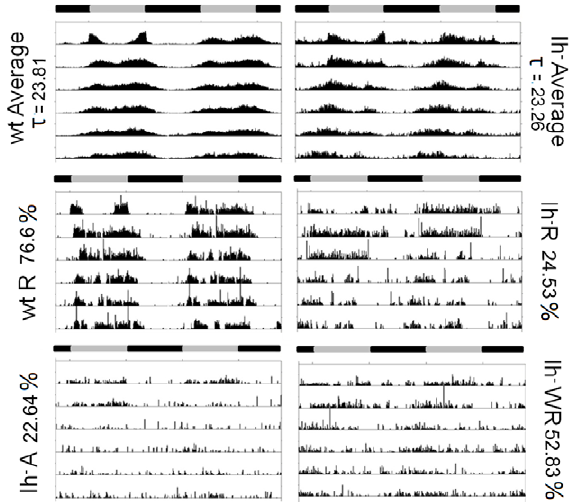
Figure 9. In constant dark, DmIh mutant flies shorten the circadian period. Average (top) and single fly representative (middle and bottom) double-plotted actograms of control and DmIh mutant flies in DD conditions. Flies were entrained for three days in LD conditions prior to being released to DD. The first day of each actogram corresponds to the last day in LD. Mutant flies included rhythmic flies (Ih-R), weakly rhythmic flies (Ih-WR), and arrhythmic flies (Ih-A) (see Table 1 for circadian parameters). Rhythmic mutant flies display a shorter period and a failure to maintain the activity plateau during the subjective